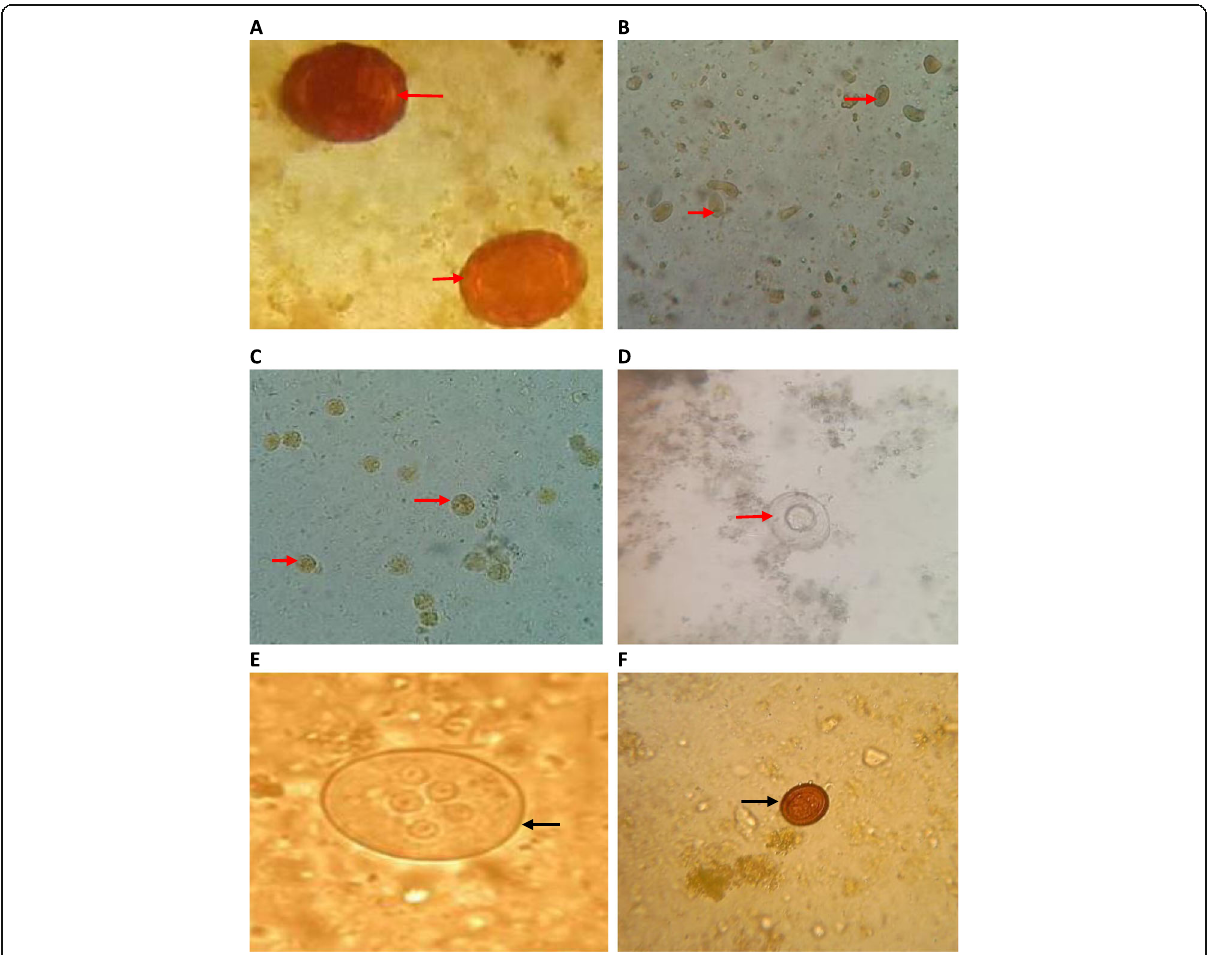
Fig. 2 Microscopic observation of intestinal parasites. a Eggs of A . lumbricoides (sample code-1126S). b Oval shape cysts of G . lamblia (sample code-1033S). c Cysts of Entamoeba histolytica -like protozoa (sample code-1013S). d Egg of Hymenolepis nana (sample code-1056S). e Cyst of Entamoeba coli (sample code: 1106S). f Egg of Taenia spp. (sample code-1217S). Solid arrow indicates egg or cyst of